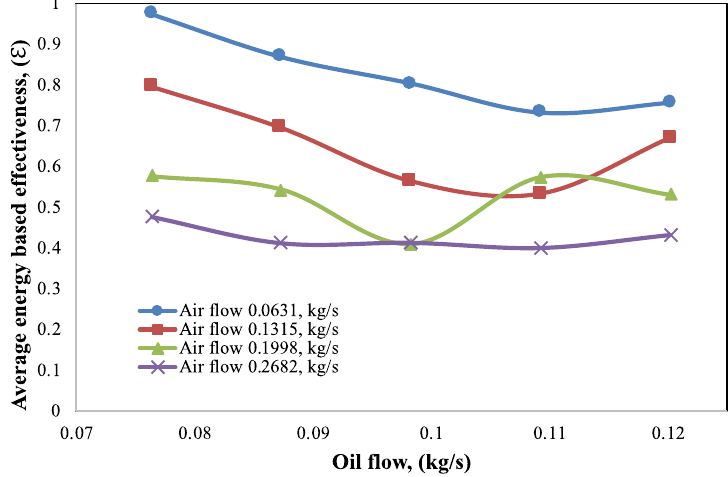
Figure 16. Average energy-based effectiveness ℇ at different air and oil flow rates.